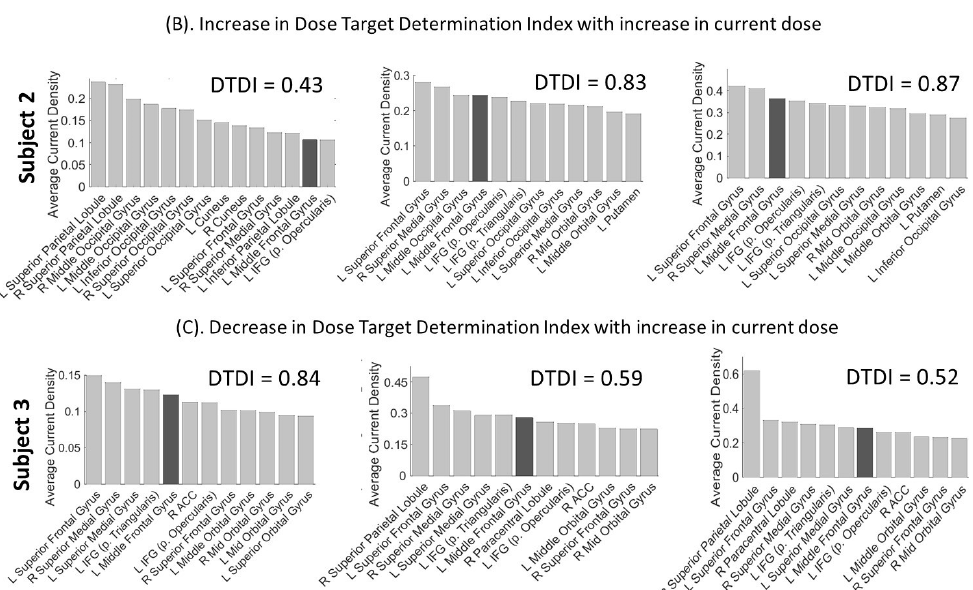
Figure 2. Illustration of the variation in DTDI for three current doses (1 mA, 2 mA, and 3 mA) with F3-RSO montage applied over three individuals showing: ( A ) no change in DTDI with an increase in current dose; ( B ) increase in DTDI with an increase in current dose; and ( C ) decrease in DTDI with an increase in current dose. Subject 1, with no change in DTDI, is neutral to variation in current dose, and the dose can be adjusted based on the intensity of the stimulation desired at the target ROI. Subject 2, showing increase in DTDI, would receive adequate stimulation from a higher dose (above 1 mA), whereas subject 3, showing a decrease, will most likely benefit from the lower dose (1 mA).